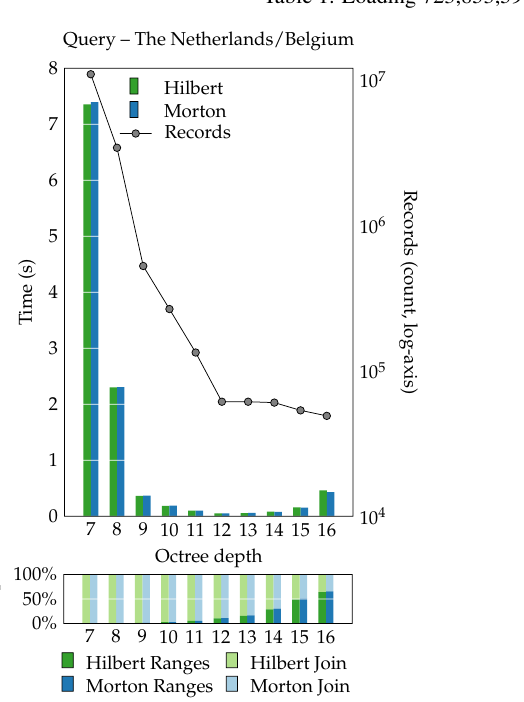
Table 1. Loading 723,853,597 records, time in hours